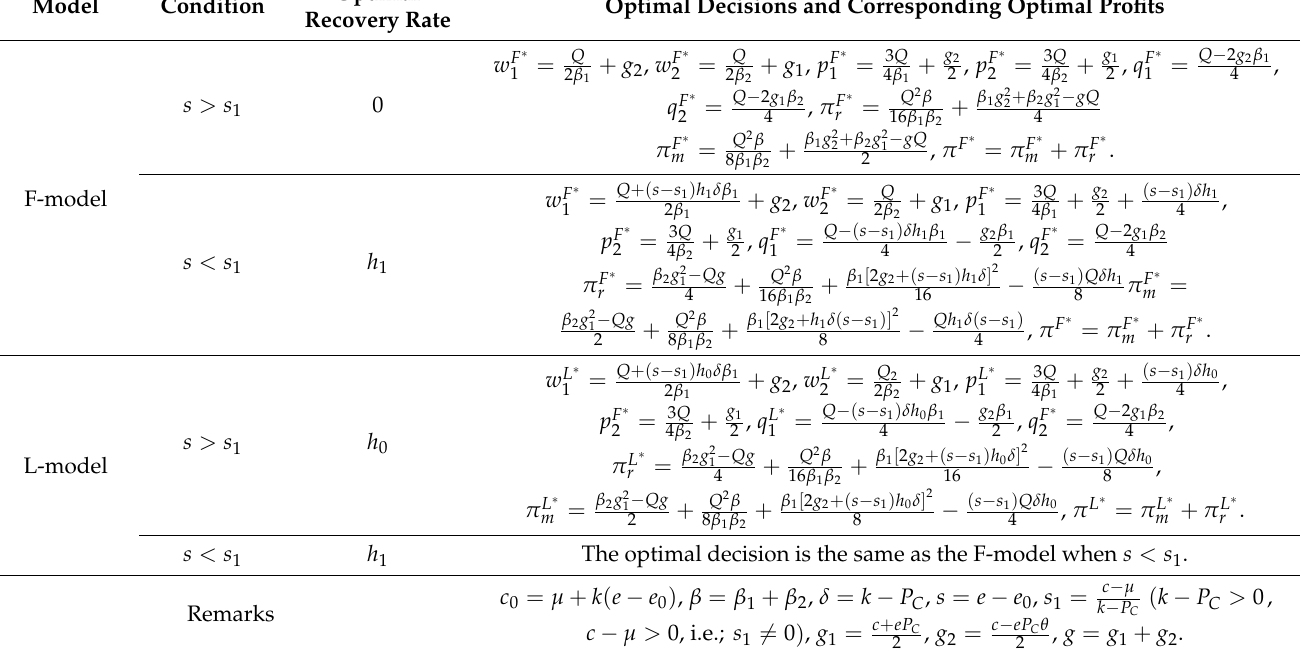
Table 3. Optimal decisions with the corresponding optimal profits. Optimal Optimal Decisions and Corresponding Optimal Model